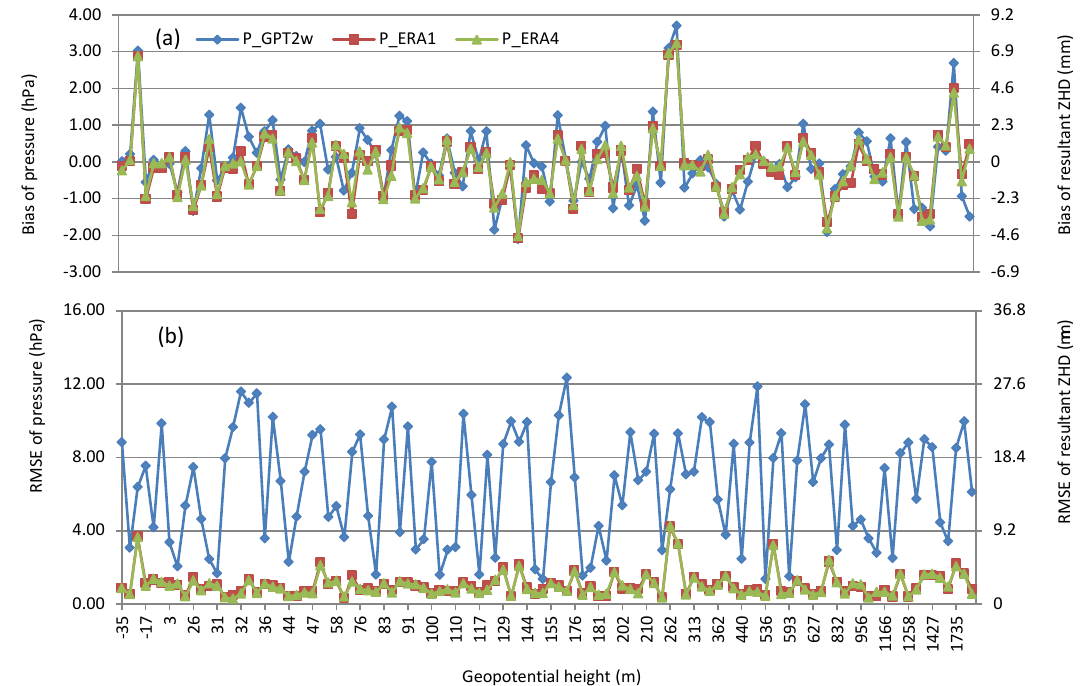
Figure 3. Distribution of biases (a) and RMSEs (b) of 6h P_GPT2w, P_ERA1 and P_ERA4 with heights across 108 GNSS stations for the period of